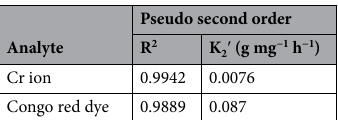
Table 1. Psuedosecond-order kinetic model constant for Cr (VI) and CR